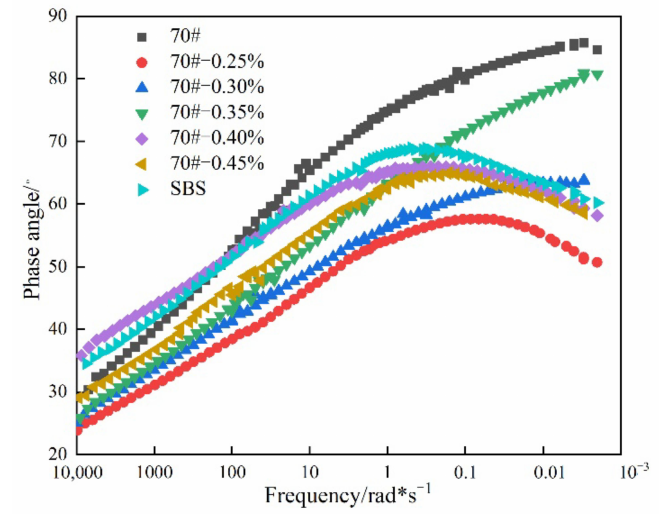
Figure 7. Master curves for the phase angle of the asphalt